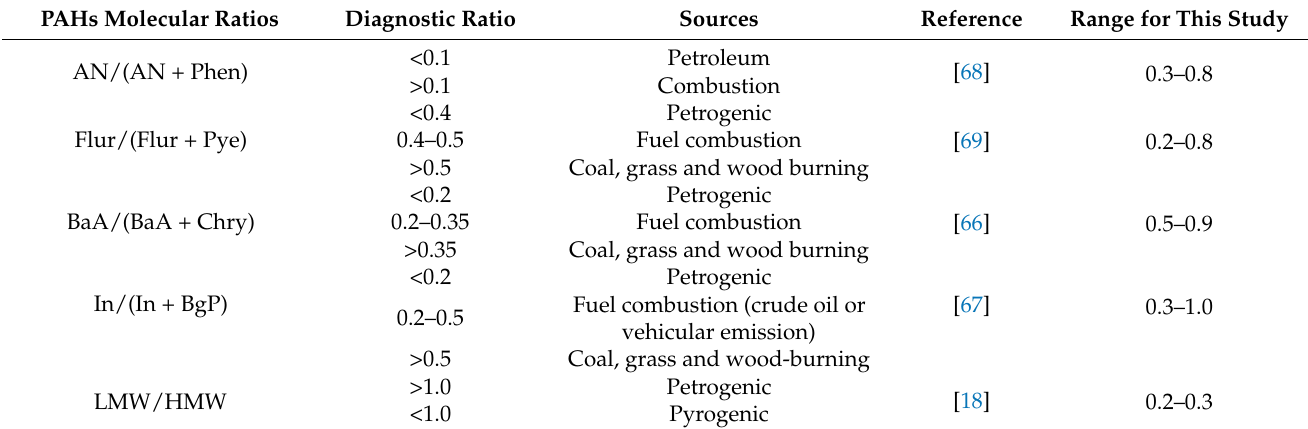
Table 4. Guidelines for PAHs diagnostic ratios considered for identifying sources of PAHs in the sediment samples of the study